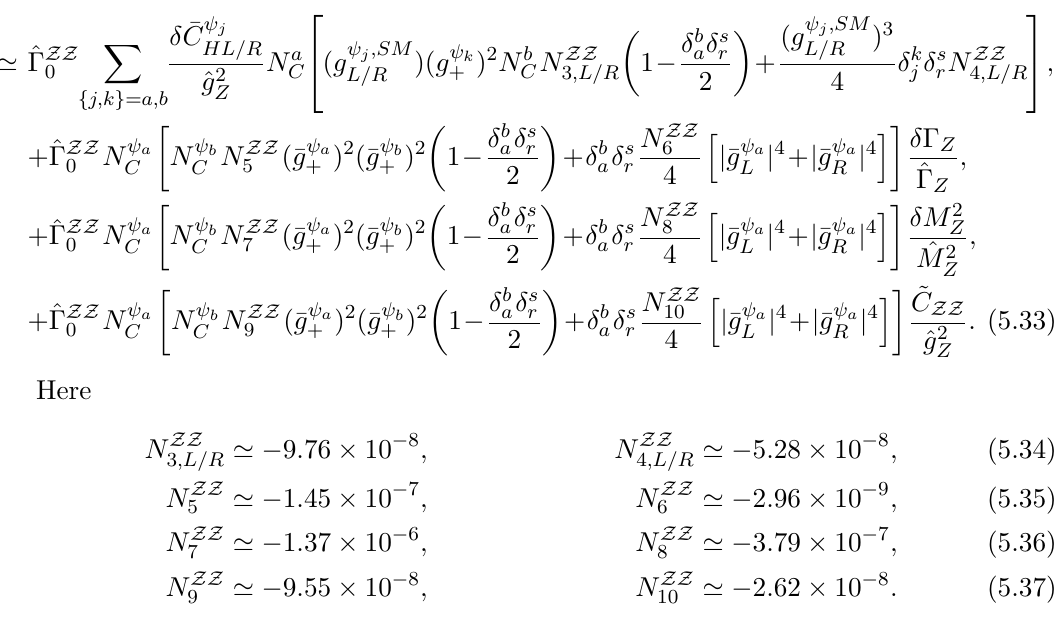
Figure 3 . Interference of Z; A; G neutral current contributions to h ! 4